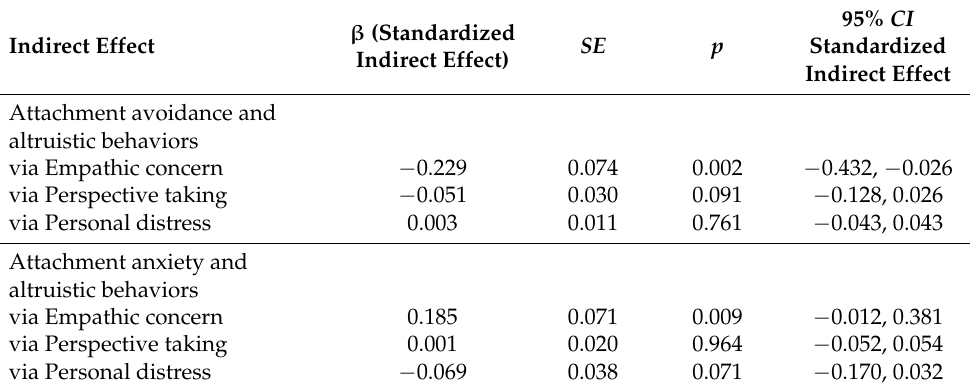
Table 3. Standardized indirect effects of attachment avoidance and anxiety on altruistic behaviors via empathic concern, perspective taking, and personal